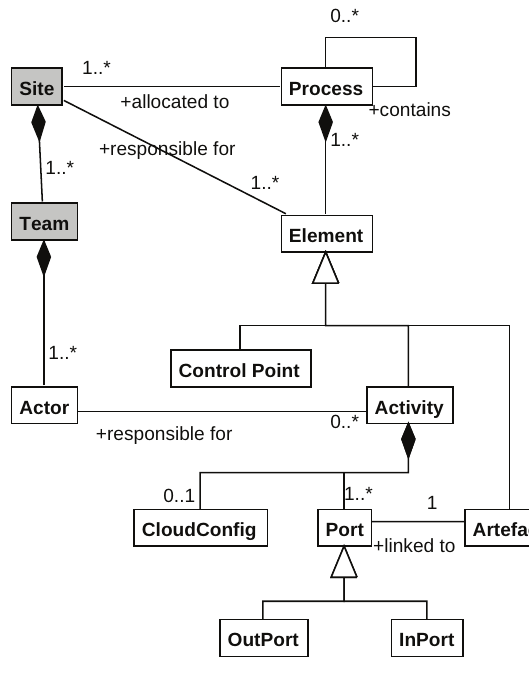
Fig. 3. The software process model XML